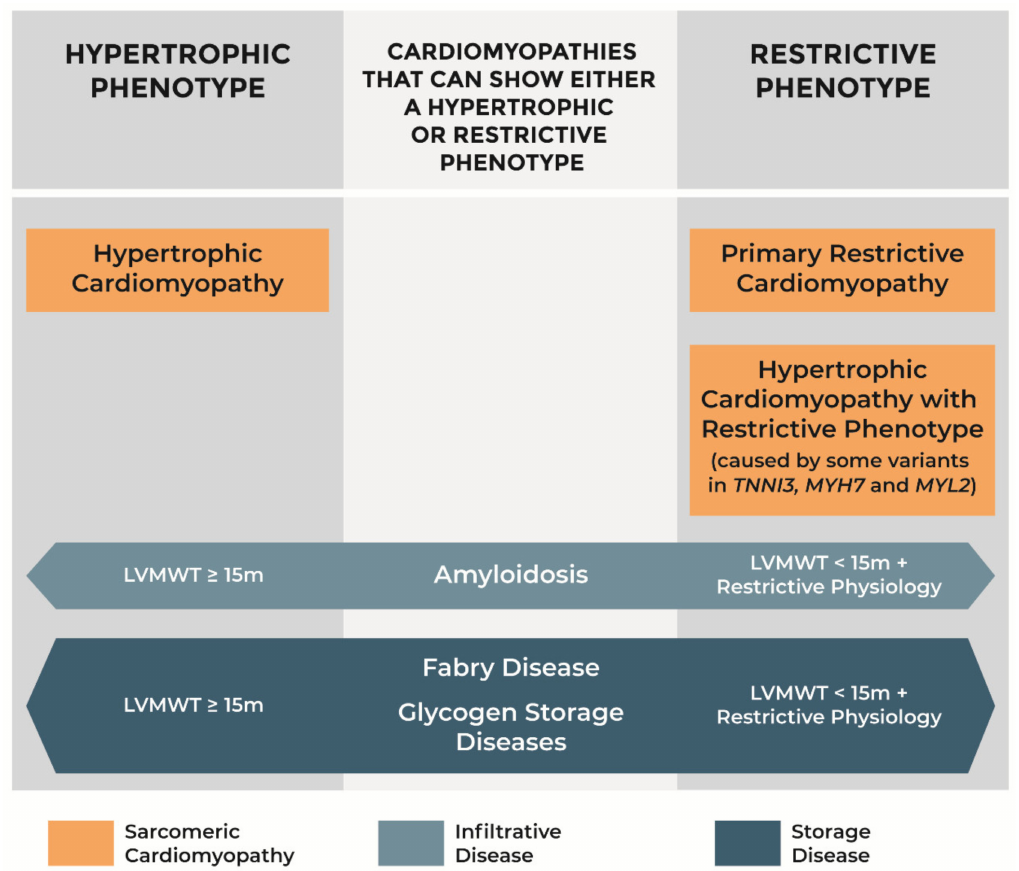
Figure 4. Phenotypes of hypertrophic cardiomyopathy, primary restrictive cardiomyopathy, amyloidosis, Fabry disease, and glycogen storage diseases. LVMWT: left ventricular maximal wall